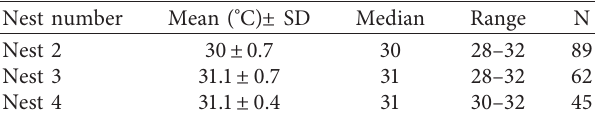
Table 1: West African dwarf crocodile incubation temperature ( ° C); SD and N represent standard deviations and the total number of recordings used for the calculations, respectively. Differences in N are a result of the difference in the number of days incubation temperature was monitored before hatching occurred and loggers were stopped after hatching